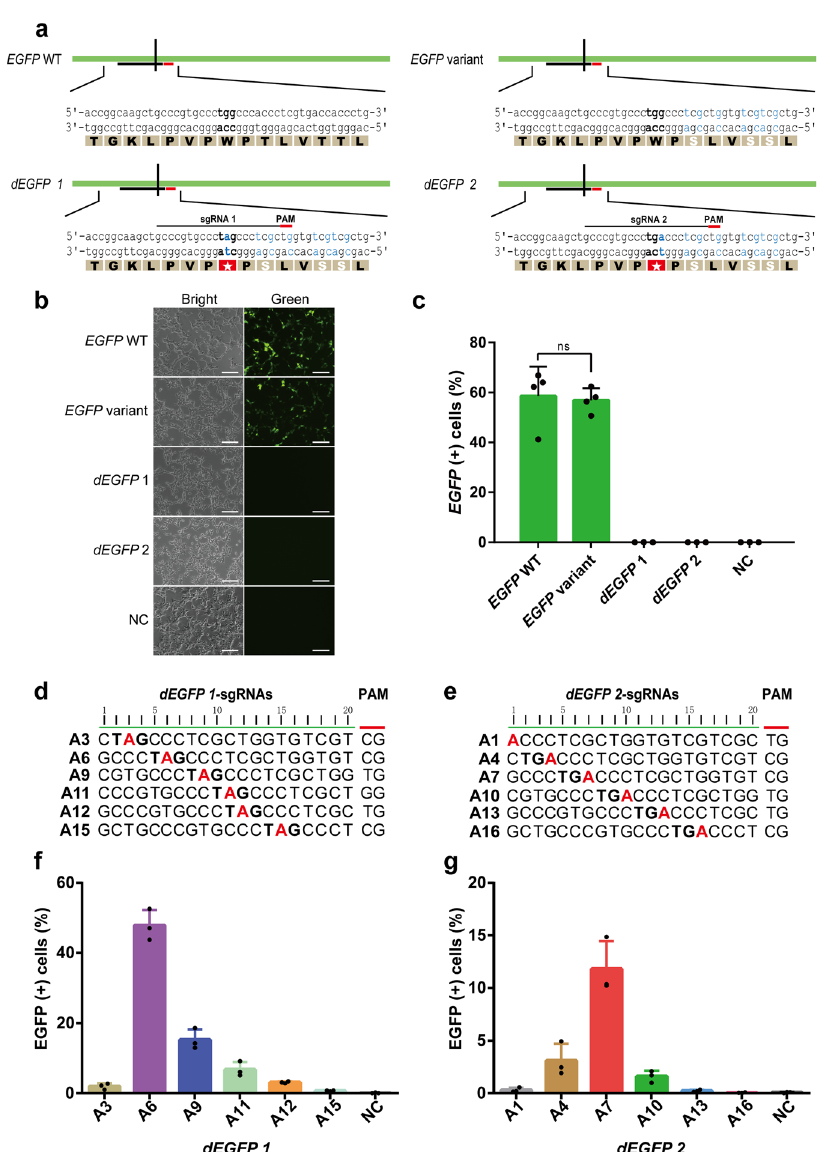
Fig. 1 Design of the stop codon reversion-based screening system. a Different EGFP variants. Single-nucleotide conversions are indicated by blue and residue substitutions are indicated by white. The stop codon was highlighted with red pentagram. b , c Fluorescence image ( b ) and editing ef fi ciencies ( c ) of HEK-293 cells co-transfect with EGFP WT, variant, dEGFP 1 and dEGFP 2, respectively. EGFP variant maintains the expression, while dEGFP 1 and dEGFP 2 abolish the expression. ( c ) EGFP positive cells were quanti fi ed by fl ow cytometry. Scale bar, 10 μ m. Data are shown as the average mean ± s.d. ( n = 4 independent experiments). d , e The sequence of different sgRNAs (5- ‘ NG-3 ’ PAM) for dEGFP 1 and dEGFP 2, respectively. The stop codon and target A base have been highlighted in bold and red. f , g Editing ef fi ciencies of A to G mutations at different positions of dEGFP 1 and dEGFP 2. Data are shown as the average mean ± s.d. ( n = 3 independent experiments). Source data are available in the Source data fi